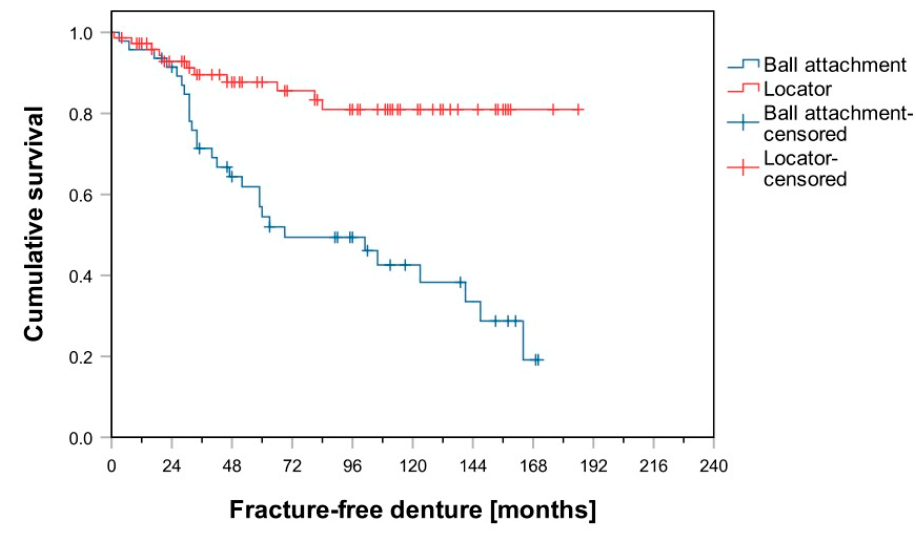
Figure 2. Kaplan–Meier survival curves for ball and Locator attachments regarding matrix-related events.